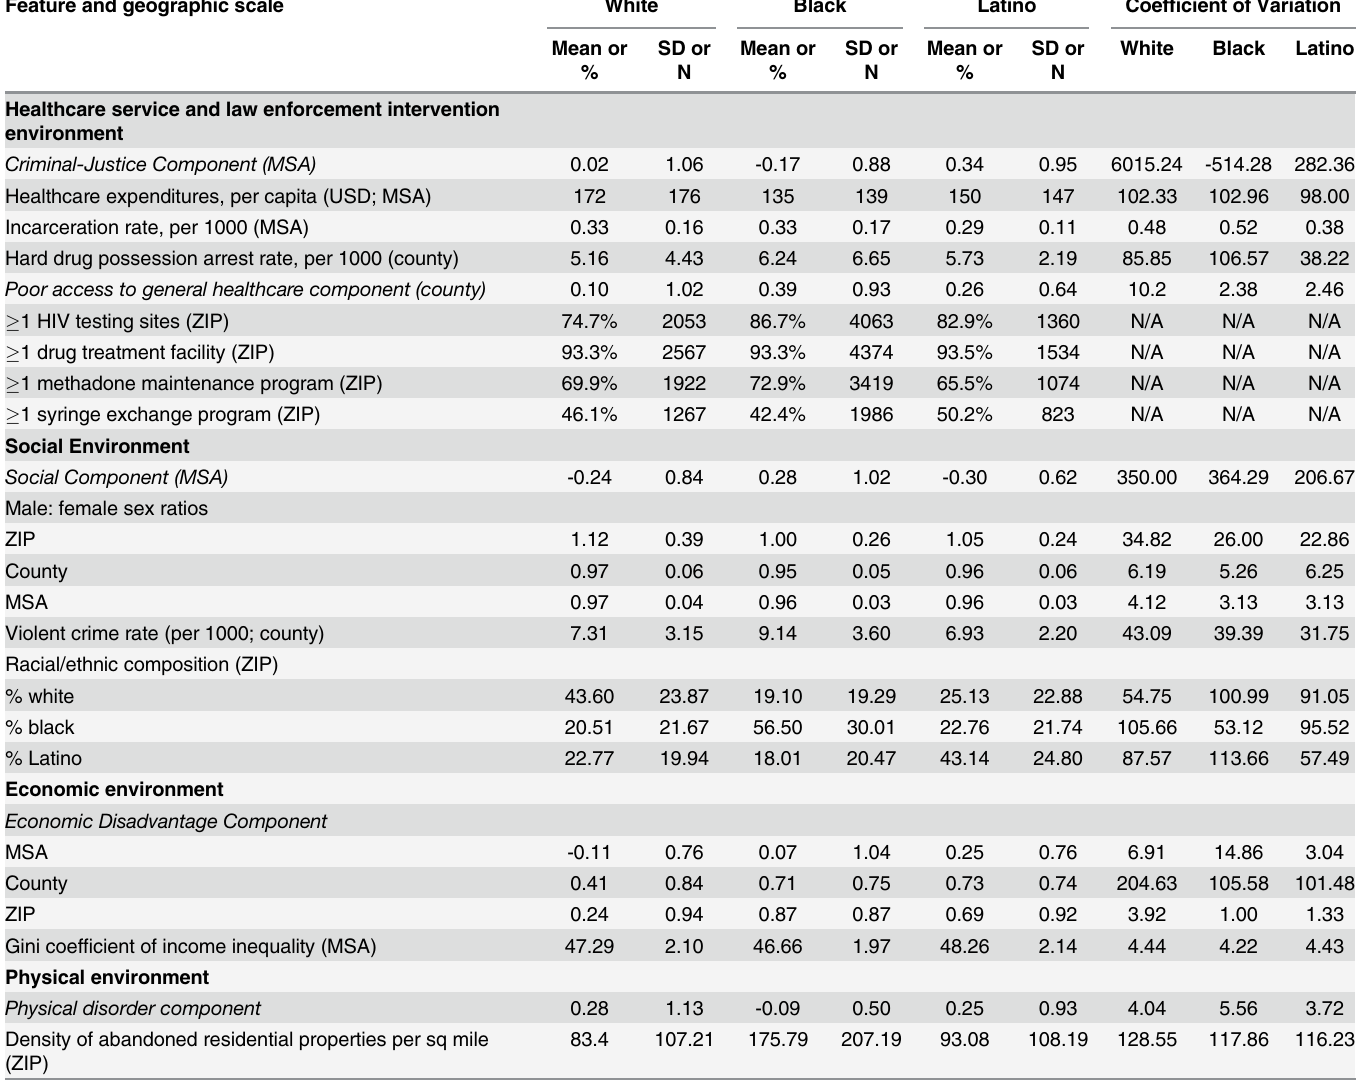
Table 4. Characteristics of the ZIP Codes (N = 968), Counties (N = 51), and Metropolitan Statistical Areas (MSAs; N = 19) where the 9,077 partici- pants of the 2009 Centers for Disease Control and Prevention ’ s National HIV Behavioral Surveillance Lived, by Racial/Ethnic Group 1 . Feature and geographic